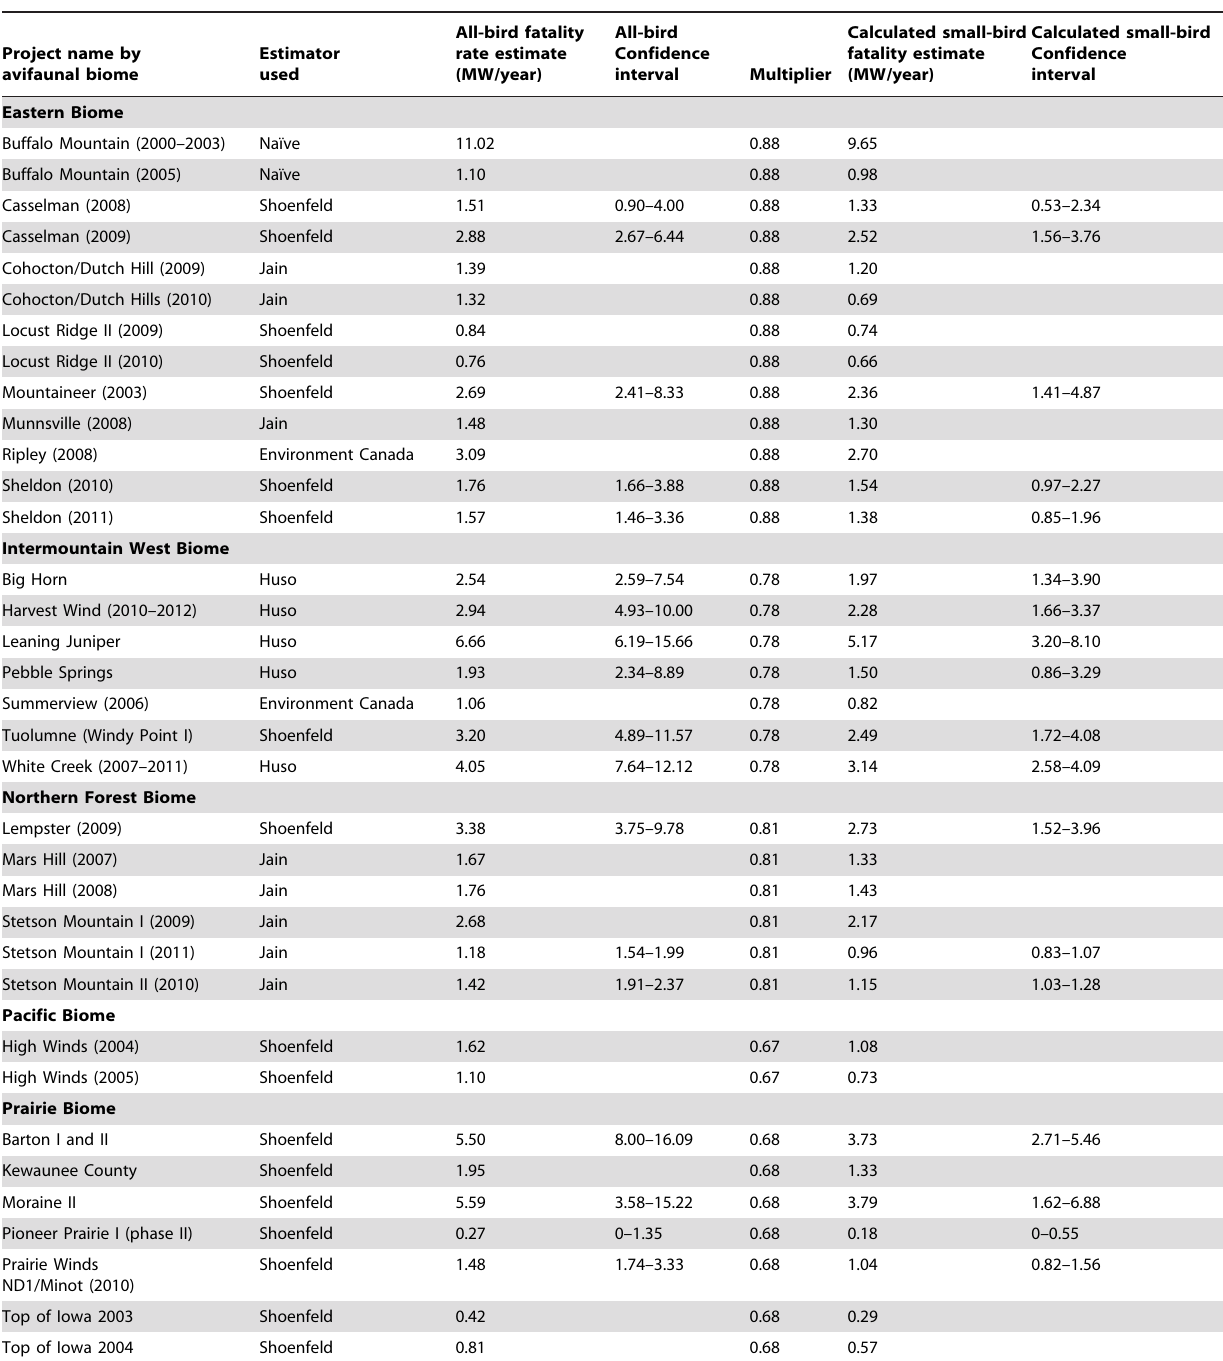
Table 2. Estimated fatality rate (birds/megawatt(MW)/year) and confidence interval calculated for small birds in studies of bird collisions at wind energy facilities that provided all-bird estimates only in their report, along with estimator, all-bird rate and confidence interval, and multiplier value a